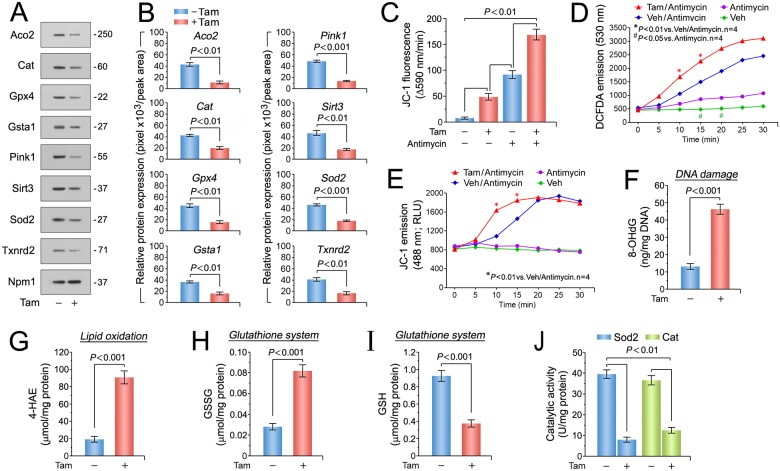
Enhanced oxidative stress and impaired antioxidant systems in cardiomyocytes lacking Mdm2.(A) Immunoblot analysis of key genes selected from top-ranked gene sets identified in Fig 3C involved in detoxification processes of reactive oxygen species (ROS). One representative immunoblot of 3 independent experiments is shown. Left ventricular samples from Mdm2f/f;mcm mice were analyzed at 7 days post-Tam. (B) Densitometric analysis of Western blot results shown in Fig 5A employing ImageJ software. Numbers at the bottom of each panel indicate fold-change. n = 3 (C) Isolated cardiac mitochondria from Tam-treated Mdm2f/f;mcm have a membrane potential (MMP) that is susceptible to ROS-induced depolarization. Mitochondria were mechanically isolated, incubated with JC-1 (5.0 ug/mL), and were then treated with antimycin (50 uM). JC-1 emission at 535/595 nm was recorded at 1 reading/min for 30 min using a fluorescence spectrophotometer. The rate between two time points (emission at 595 nm/min) was calculated in the most linear range of decline for JC-1 fluorescence intensity. n = 4. (D) DCFAD (dichlorofluorescin diacetate) emission data in isolated cardiac mitochondria from Tam-treated Mdm2f/f;mcm mice. n = 4. (E) JC-1 green emission data in isolated cardiac mitochondria from Tam-treated Mdm2f/f;mcm mice. RLU, relative light units. n = 4. (F) Higher oxidative genomic DNA damage in Mdm2f/f;mcm mice post-Tam when compared to vehicle-injected controls. Concentrations of 8-hydroxy-2’-deoxyguanosine (8-OHdG), a biomarker for oxidative DNA damage in the indicated strains was determined by a competitive enzyme-linked ELISA employing 8-OHdG antibodies. n = 4. (G) Significantly enhanced levels of 4-hydroxyalkenals (4-HAE), an indicator of ROS-dependent lipid peroxidation in Mdm2f/f;mcm mice post-Tam compared with control injected animals. n = 4. (H and I) Markedly reduced glutathione/oxidized glutathione (GSH/GSSG) ratios, an indicator of cardiac oxidative stress, in Mdm2f/f;mcm mice post-Tam compared to controls. n = 4. (J) Significantly downregulated mitochondrial superoxide dismutase (Sod2) and catalase (Cat) activities as determined spectrophotometrically in Mdm2f/f;mcm mice post-Tam. n = 4. Fig 5A to J: Left ventricular samples from 12-week-old mice were analyzed at 7 days post-Tam. Fig 5 data are means±s.e.m.